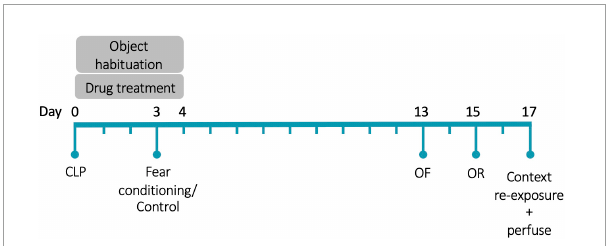
FIGURE1 Experimental timeline. CLP, cecal ligation and puncture; OF, open field; OR, object recognition. N = 80 animals (20 animals/group, half